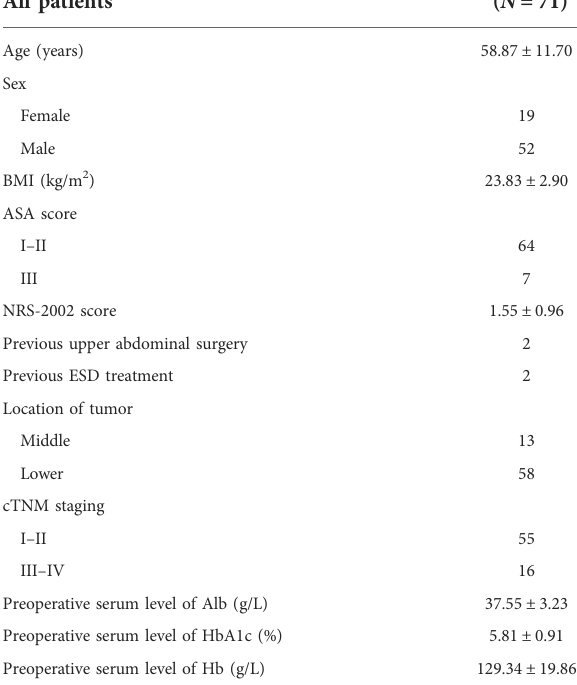
TABLE 1 Demographics of 71 patients who underwent the modi fi ed Roux-en-Y reconstruction. All